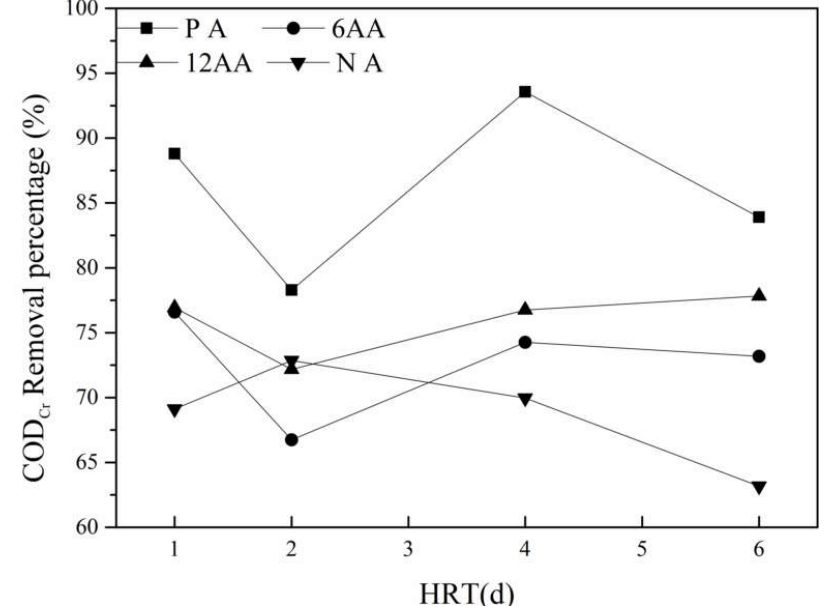
Figure 3. The COD Cr removal efficiency in HSSF-CWs with different aeration modes with increasing HRT (PA: Pre-aeration at 24 hours before the input of influent water; 6AA: Aeration at 6 hours after the input of influent water; 12AA: Aeration at 12 hours after the input of influent water; NA: Non-aeration). HRT: hydraulic retention time.